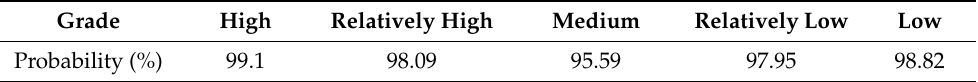
Table 5. The probabilities of correct classification for alarm messages.